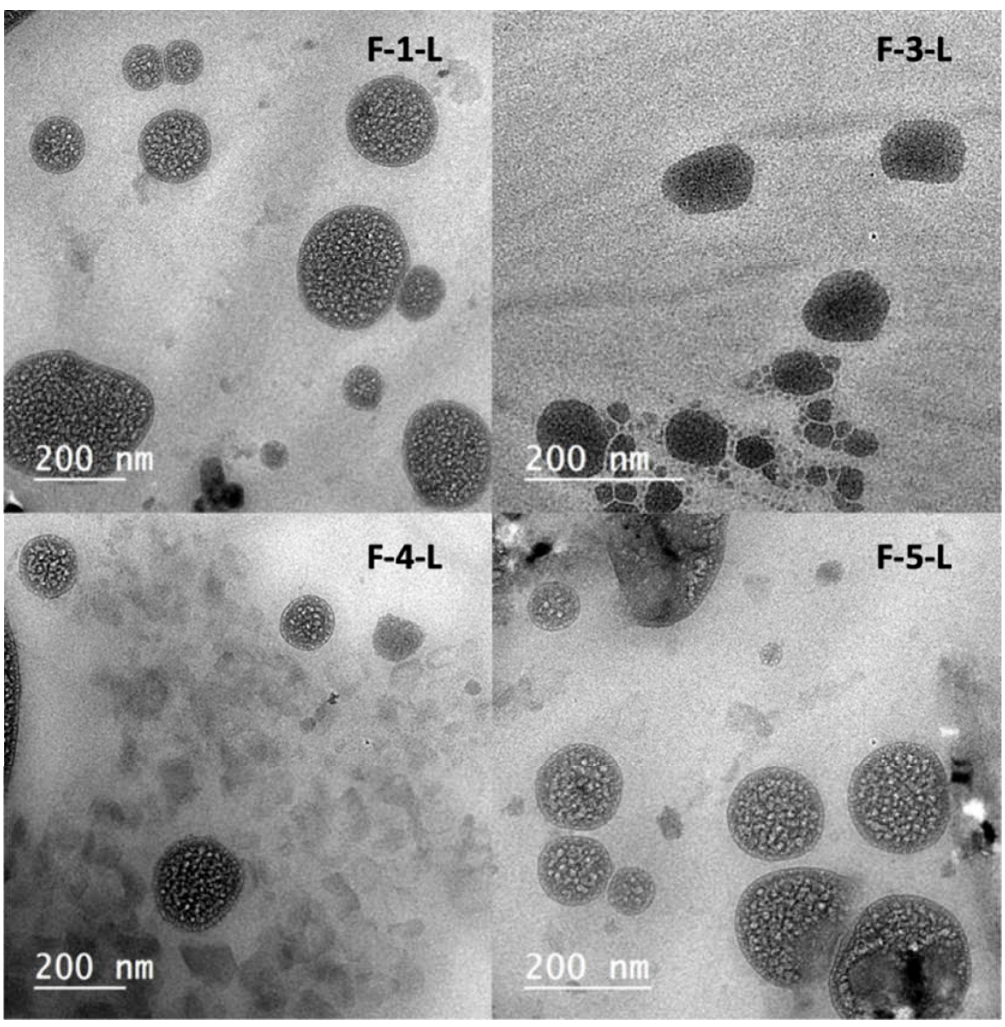
Figure 4. TEM photomicrographs showing the morphology of representative TRAVO-loaded LCNs (F-1-L, F-3-L, F-4-L, and F-5-L).